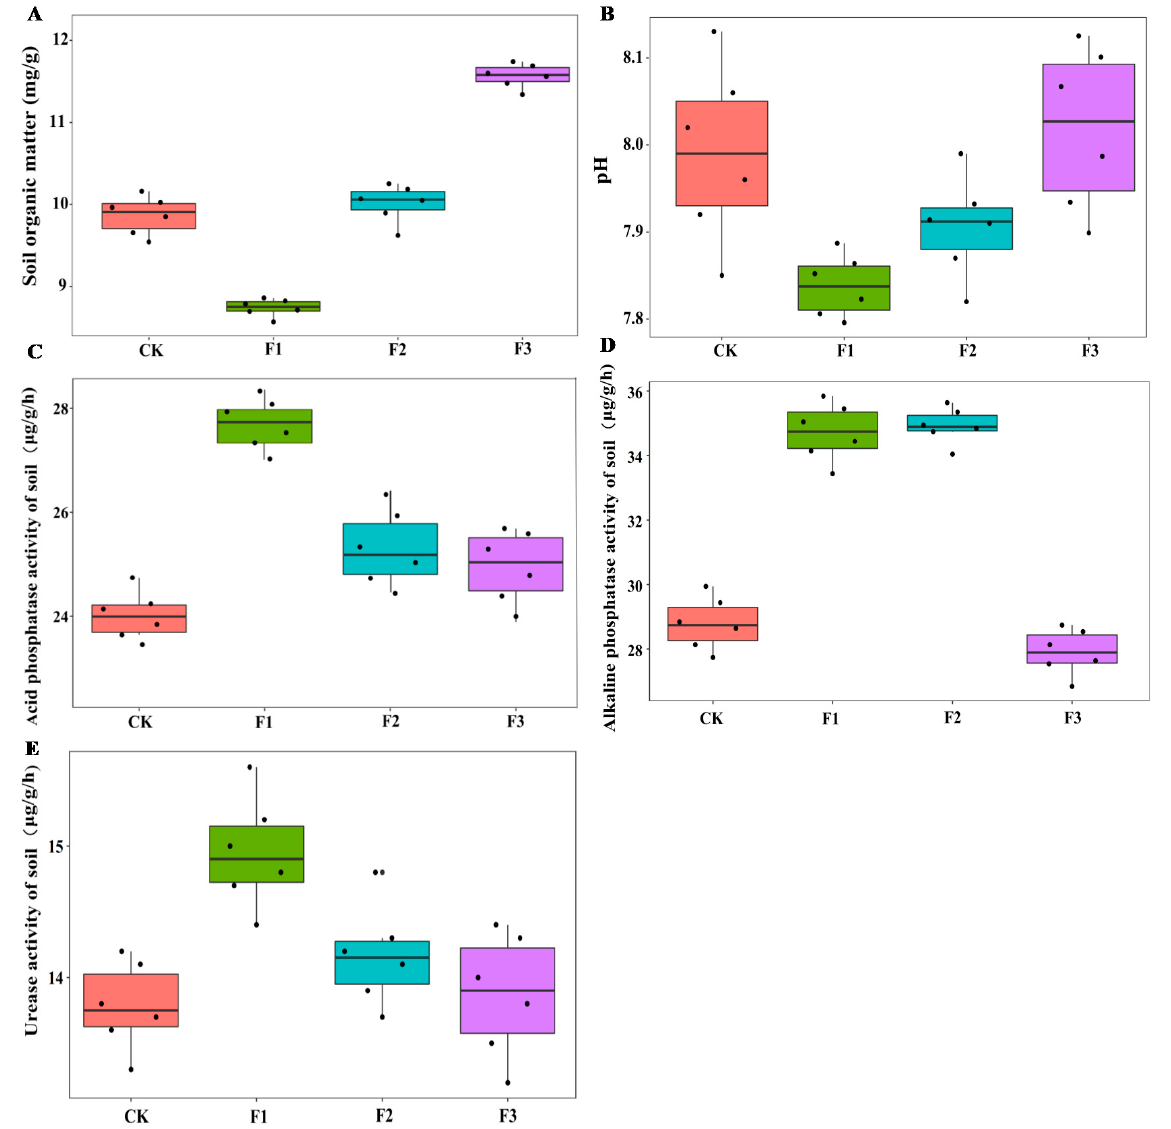
Figure 4. Effects of different foliar fertilizer on soil enzyme activities of Chinese yam. Organic matter content in rhizosphere soil of yam under different foliar fertilizer treatments ( A ); pH in rhizosphere soil of yam under different foliar fertilizer treatments ( B ); Acid phosphatase activity in rhizosphere soil of yam under different foliar fertilizer treatments ( C ); Alkaline phosphatase activity in rhizosphere soil of yam under different foliar fertilizer treatments ( D ); Urease activity in rhizosphere soil of yam under different foliar fertilizer treatments ( E ). CK, spray with water; F1, NPK foliar fertilizer;